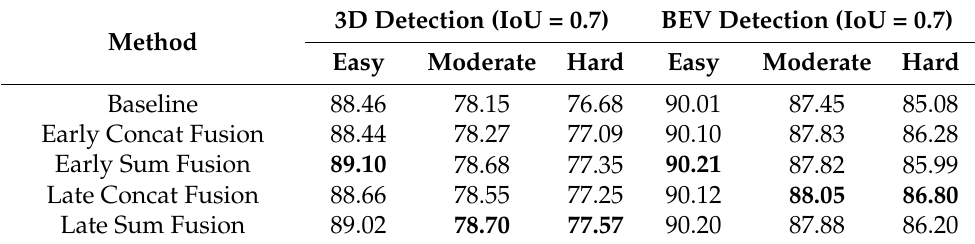
Table 3. Performance comparison of different fusion methods on the KITTI validation